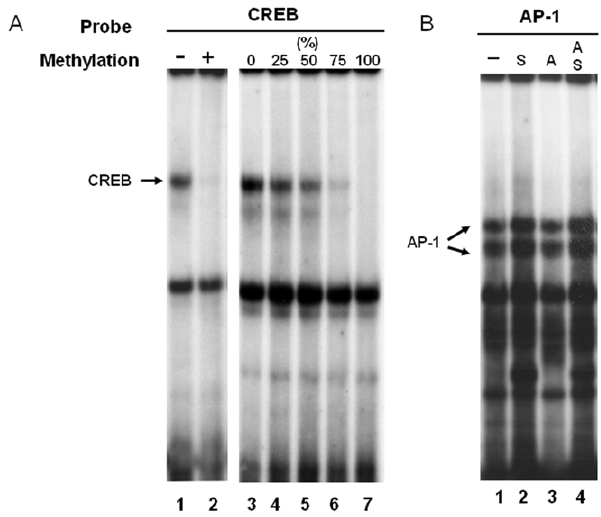
Figure 7. The influence of methylated CpG sites on the binding activities of CREB and AP-1. The representatives of four indepen- dent EMSA assays in each experiment are shown. Left: nuclear extracts from cortical neuronal culture were incubated with end-labeled double- stranded oligonucleotides with nonmethylated (Lane 1) and methylated (Lane 2) CpG 32 within CRE site. Right: nuclear extracts were incubated with probes incorporated with methylated CpG32 in 0%, 25%, 50%, 75% and 100% (Lane 3 , 7). 2. The probes of oligonucleotides containing AP-1 binding site from nonmethylated (Lane 1), hemi- methylated in sense (S, Lane 2) and anti-sense (A, Lane 3) and methylated (Lane 4) were used in EMSA. Since we have previously identified CREB [38] and AP-1 (family) [37] proteins binding by antibodies shift assay, the arrows indicate CREB or AP-1 bands.